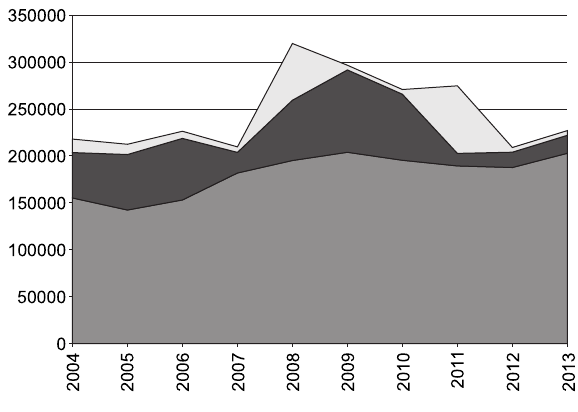
Fig. 1. Expenditures of Bratislava city-wide self- government (in thousand euros). Source: Bratislava City Magistracy: Final